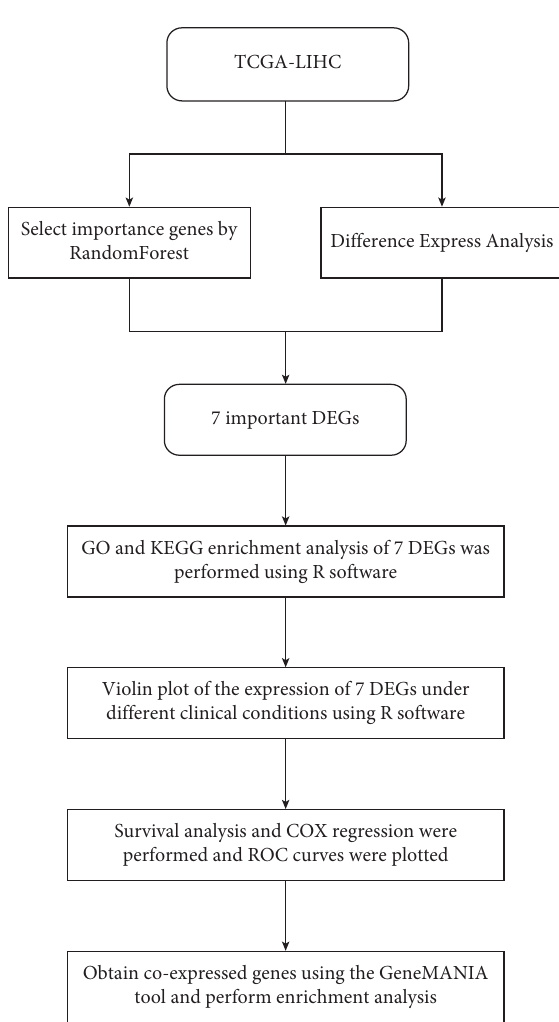
Figure 1: Flow chart of this